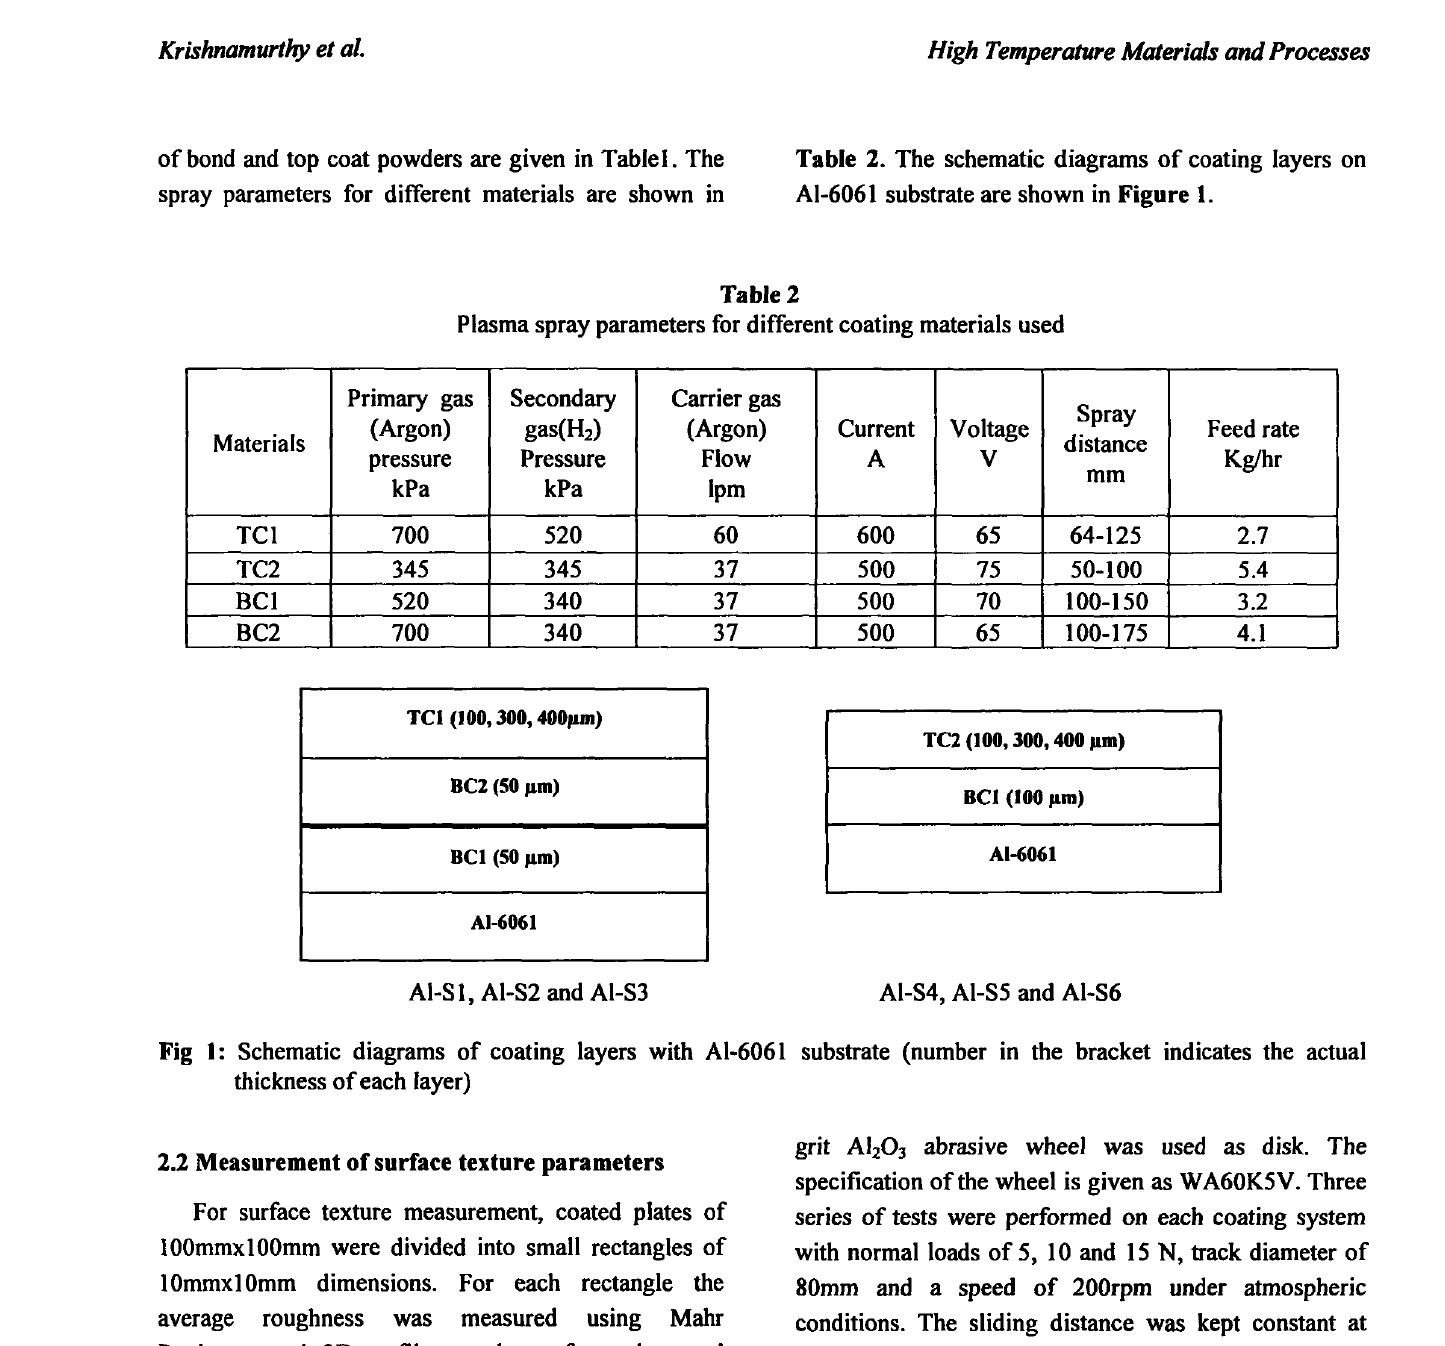
Fig 1: Schematic diagrams of coating layers with Al-6061 substrate (number in the bracket indicates the actual thickness of each